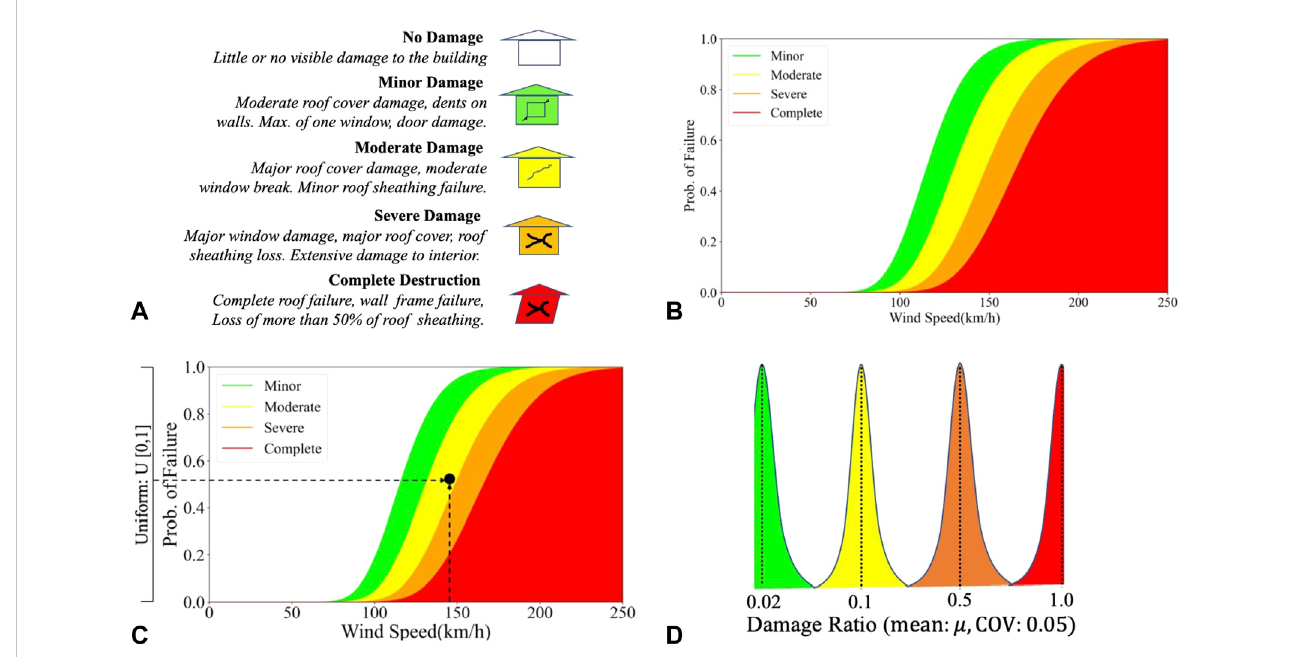
FIGURE 2 (A) Damage States, (B) Generalized fragility curves correspond to damage states, and (C) Stochastic damage simulation, and (D) Distribution of building damage